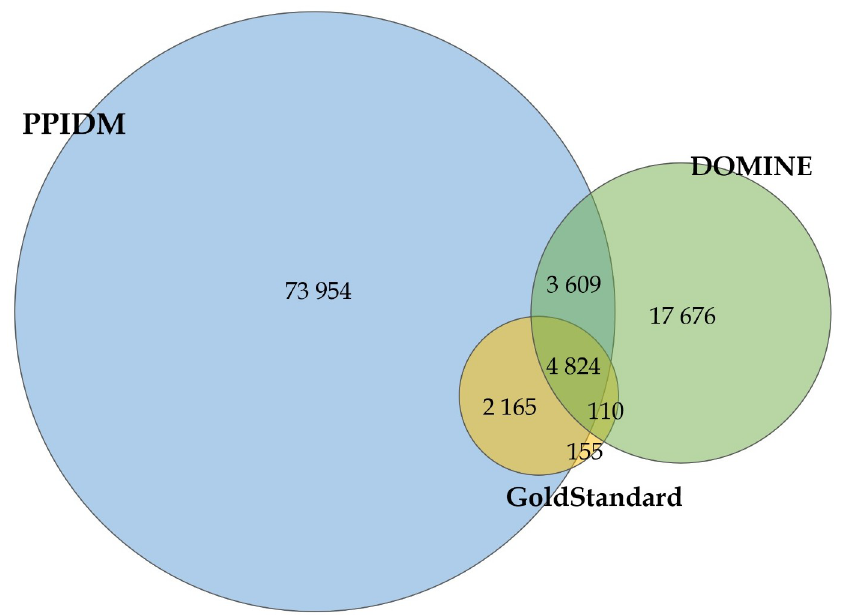
Fig 2. Venn diagram for overlapping DDIs between PPIDM (blue), DOMINE (green), and our Gold-Standard (KBDOCK \ 3did, yellow). PPIDM and DOMINE share 8,433 (3,609 + 4,824) DDIs. The Gold-Standard has 6,989 and 4,934 DDIs in common with PPIDM and DOMINE, respectively, while the Gold-Standard, PPIDM, and DOMINE share together 4,824